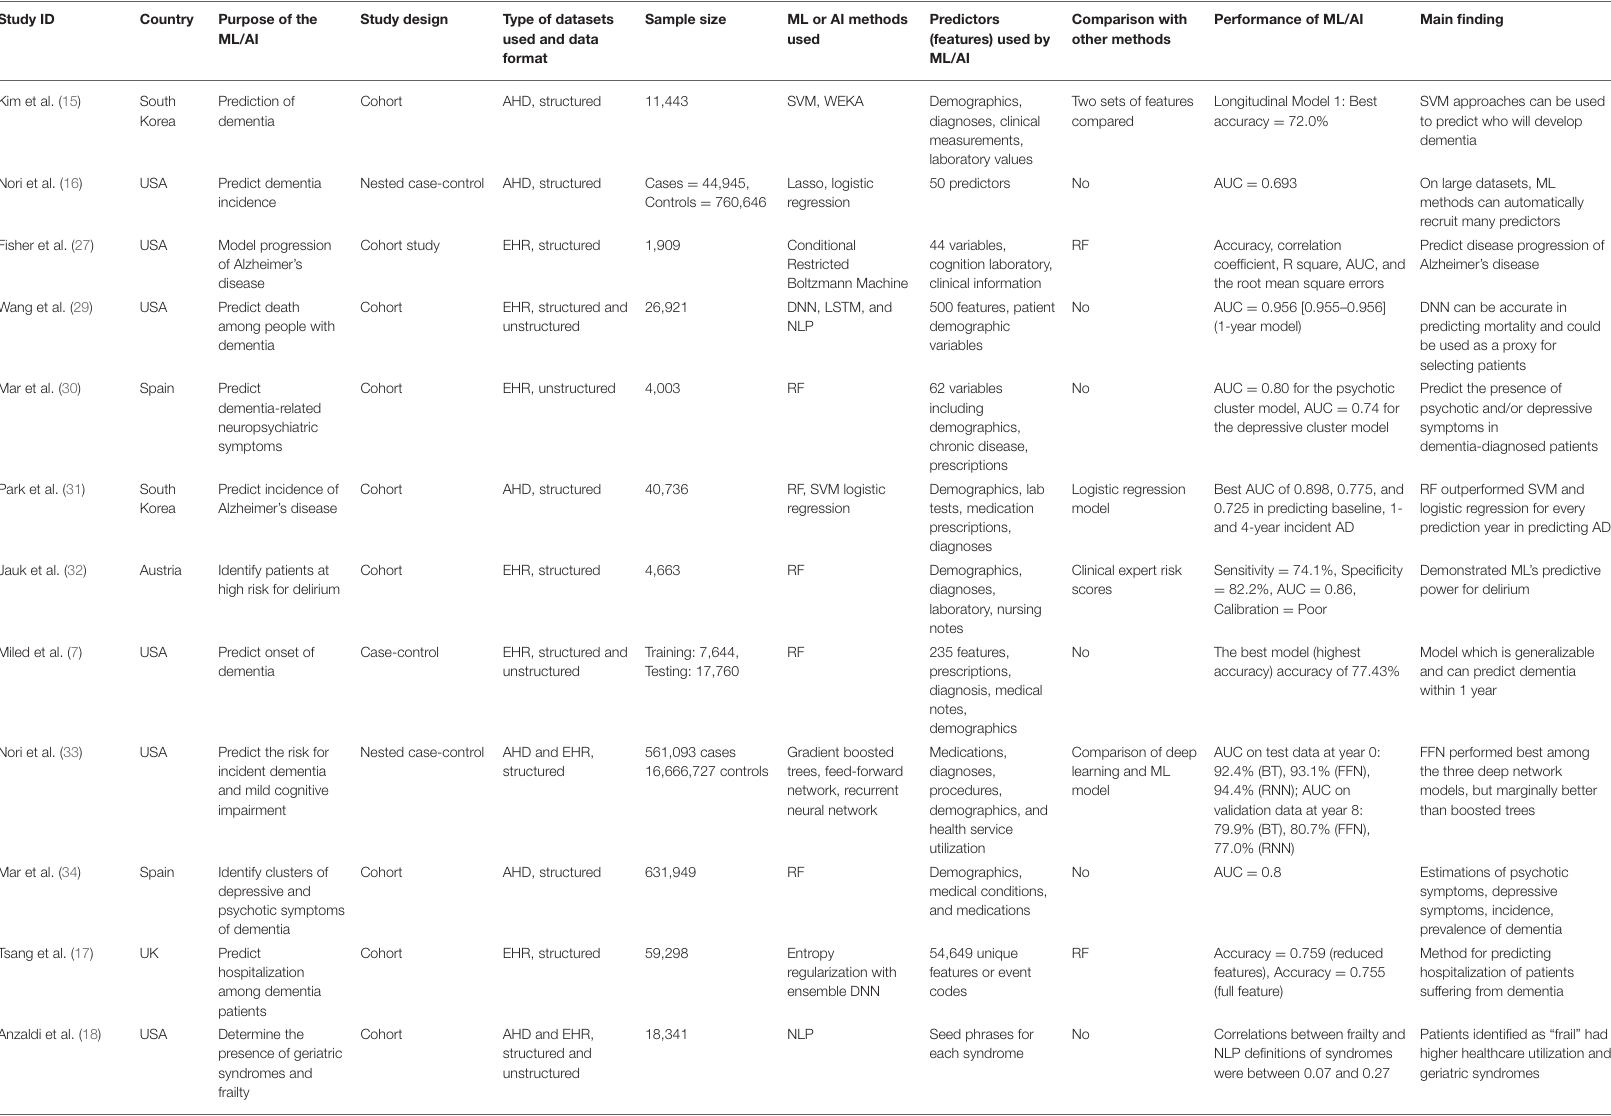
TABLE 1 | Study characteristics of the included studies. Study ID